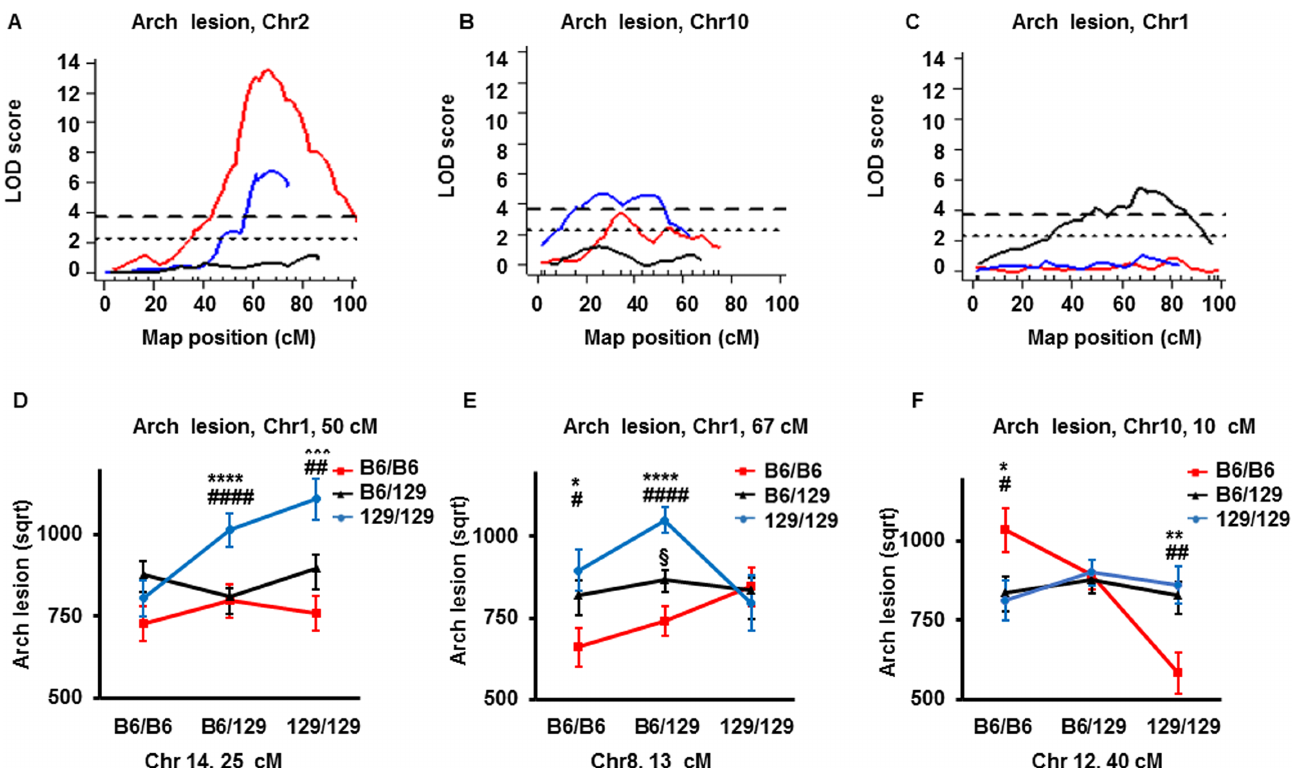
Fig 2. LOD curves and allelic distribution of QTLs for plaque lesion at arch. (A-C) LOD curves of QTL for plaquelesionsize at arch in sex- combinedscan with sex as additivecovariateof a cross betweenB6-apoE and DBA-apoE(red lines), a cross betweenB6-apoE and 129-apoEmice (black lines) and a cross betweenDBA-apoE and 129-apoEmice (blue lines) on chromosome Chr2 (A), Chr10 (B) and Chr1 (C). The horizontaldashed and dotted lines represent thresholdsfor suggestiveQTL (p = 0.63) and significantQTL (p = 0.05) determined in single locus scan of the cross between B6-apoEx DBA-apoEmice. The significance thresholdsfor LOD scores were determined by 1000 permutations using R/qtl software. (D) Allelic distributionof the QTLs for plaquelesion sizes at arch at the nearest marker to the peaks in Chr1 and Chr14 in both sexes in the cross between B6-apoEand 129-apoEmice. Data represent mean ± SE. Comparisonof lesionsizes were done by one-wayanalysisof variance (ANOVA), followed by Tukey-Kramer’s HSD-test. Only mice homozygous for 129 alleleat both Chr1 and Chr14 have significantly larger plaquescomparedto those with other combinations of the loci by one-wayANOVA (p = 0.001), followedby Tukey-Kramer’s HSD-test: *** p < 0.001–129/129 genotypevs B6/B6 genotype, ## p < 0.01–129/129 vs 129/B6genotypegenotype. **** p < 0.0001–129/129genotypevs B6/B6 genotype, #### p < 0.0001–129/129genotype vs B6/129genotype;(E) Allelic distribution of the QTLs for plaquelesionsizes at arch at the nearest marker to the peaks in Chr1 and Chr8 in both sexes in the cross betweenB6-apoEand 129-apoEmice. If Chr8:13cM is homozygousfor the 129 allele, genotypeeffects were not present, but that if at least one alleleof Chr8;13cM derived from B6, a strong effect of genotypes is revealed.Data represent mean ± SE. Comparison of lesion sizes were done by one-wayanalysisof variance(ANOVA), followedby Tukey-Kramer’s HSD-test. * p < 0.05–129/129 genotypevs B6/B6 genotype; # p < 0.05– 129/129genotypevs B6/129 genotype, **** p < 0.0001–129/129 genotypevs B6/B6 genotype; #### p < 0.0001–129/129 genotypevs B6/129 genotype; § p < 0.05-B6/B6 genotypevs B6/129 genotype. (F) Allelic distributionof the QTLs for plaquelesionsizes at arch at the nearest marker to the peaks Chr10 and Chr12 in both sexes in the cross betweenB6-apoEand 129-apoEmice. Data represent mean ± SE. 129 alleleof the Chr12 has significant protective effect only when Chr10 is homozygous for B6 alleleComparisonof lesionsizes were done by one-wayanalysisof variance(ANOVA), followedby Tukey-Kramer’s HSD-test. * p < 0.05-B6/B6 genotypevs 129/129genotype; # p < 0.05-B6/B6 genotypevs B6/129 genotype; ** p < 0.01-B6/ B6 genotypevs 129/129genotype; ## p < 0.01-B6/B6 genotypevs B6/129